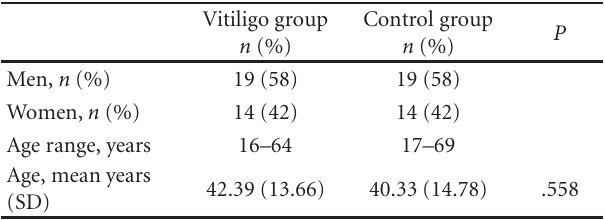
Table 1: Demographic data of patients (Vitiligo group) and volun- teers (Control group).